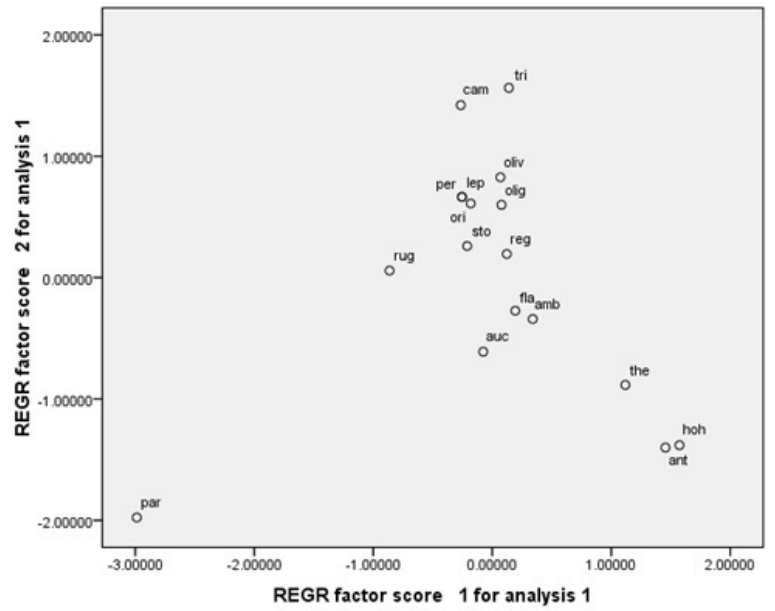
Fig. 4. PCA analysis of qualitative characters based on factor 1 and